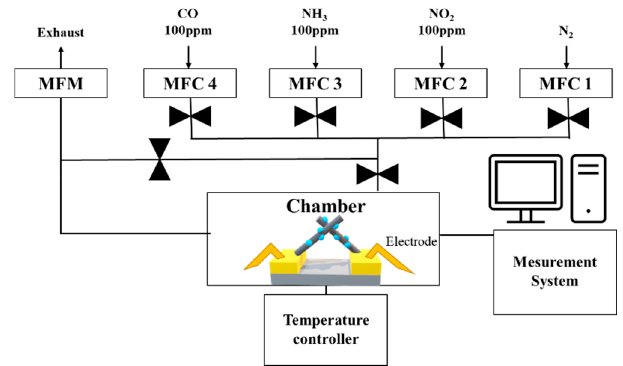
Figure 6. Architecture of the gas measurement system.